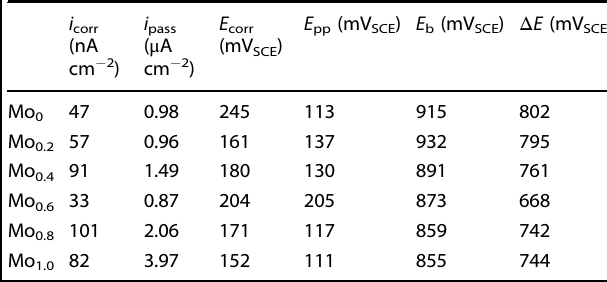
Fig. 4 Potentiodynamic and potentiostatic polarization results. a potentiodynamic polarization curves, b the enlarged region showing passive potential window, c potentiostatic polarization curves, d corresponding steady-state currents at 0.4 V SCE for 10 h, the standard deviations (error bars) of the three tests for the steady-state currents. Table 2. Key parameters from potentiodynamic polarization of CoCrFeNiMo x HEAs in 5 mM H 2 SO 4